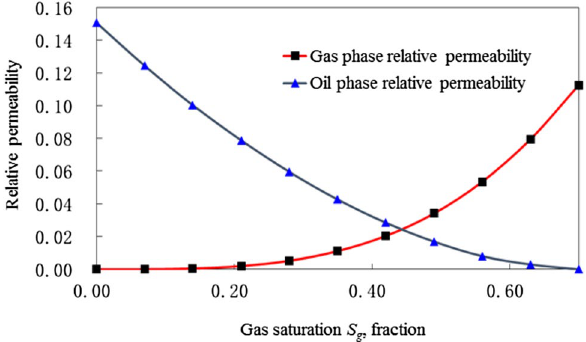
Fig. 2 Two-phase pseudo-pressure function curve considering differ- ent influence